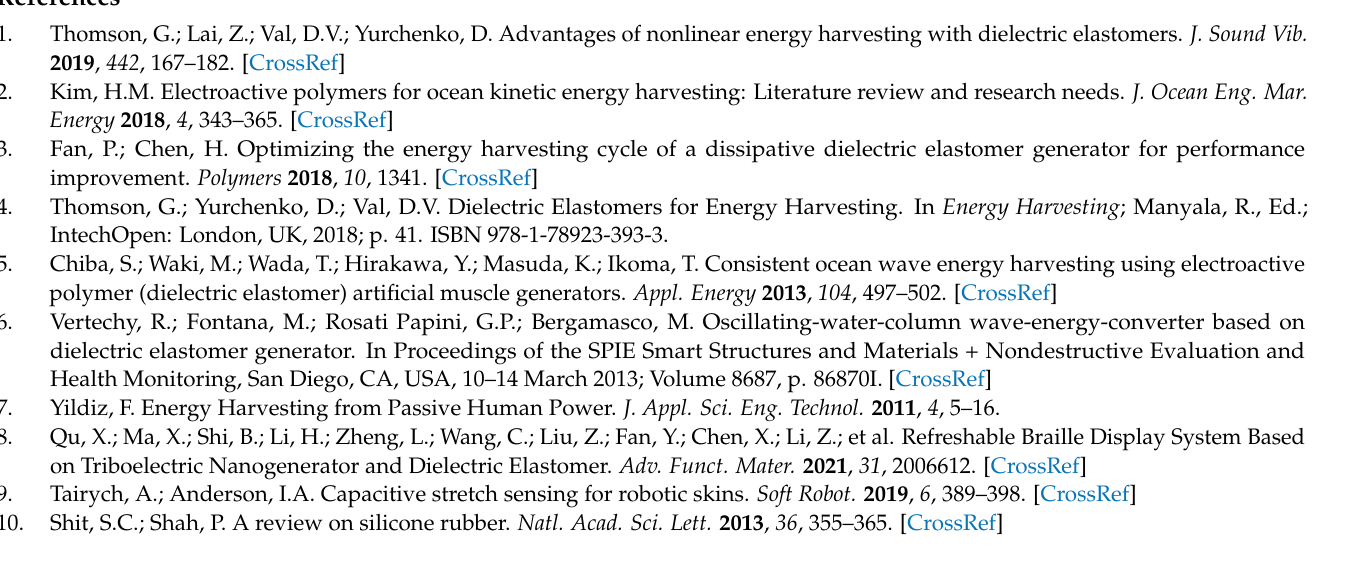
Table S1: The amounts used for obtaining the IPNs and the reference samples; Table S2: Thermal characteristics extracted from DSC data; Figure S5: Inset of DSC data emphasizing the glass transition temperature; Table S3: DMA data of reference sample A and AxCy series; Table S4: Mechanical and dielectric data of prepared samples in comparison with representative IPNs from